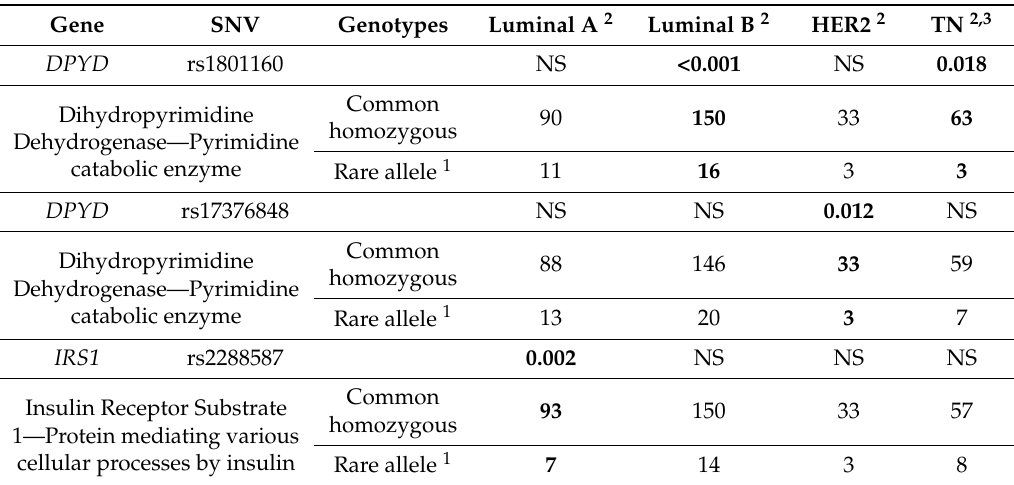
Footnotes: 1 In the absence of rare homozygotes in any of the compared groups, effect of rare allele was evaluated; 2 p -value by the log-rank test and numbers of patients (significant associations are depicted in bold); 3 Triple negative; NS = Non-significant.